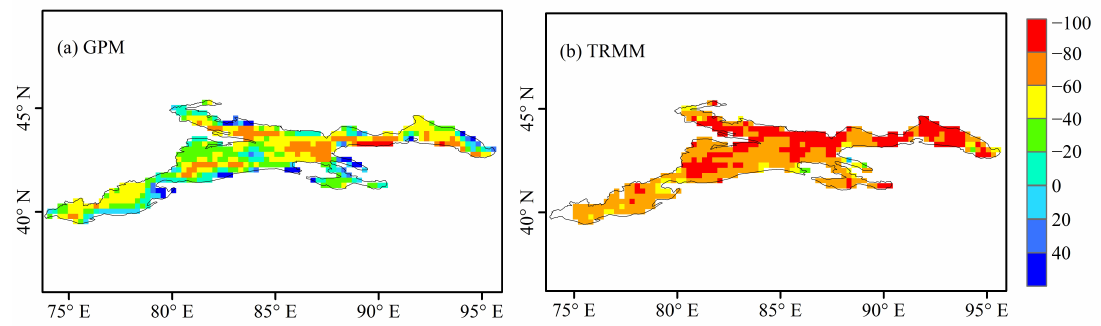
Figure 5. Relative deviation percentage of GPM, TRMM and CGDPA from 1 April 2014 to 31 March 2015.